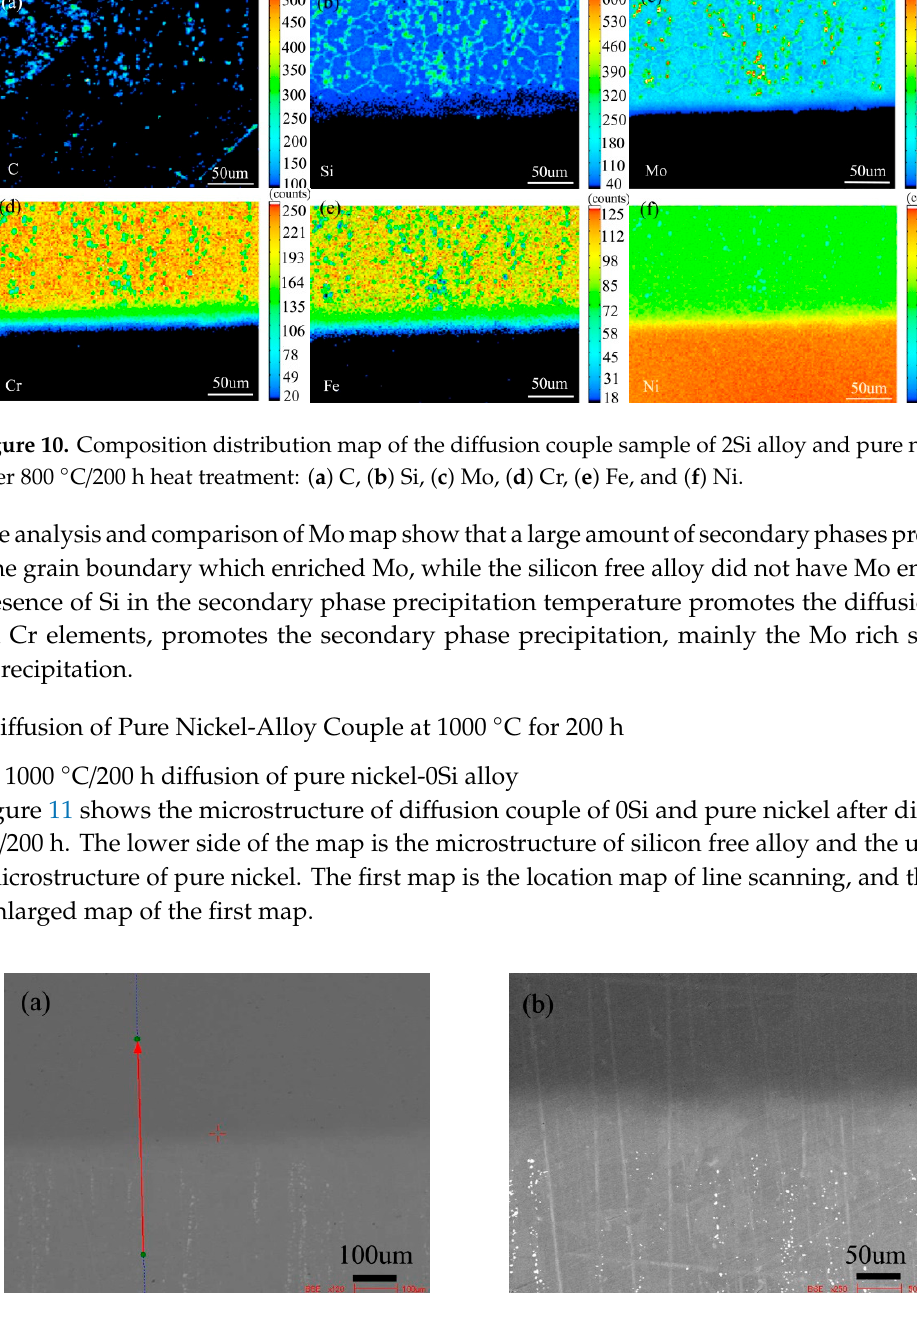
Figure 11. Microstructure of diffusion couple sample after 1000 °C/200 h heat treatment: ( a ) composition line scan position of the sample and the upper side is pure nickel material and lower side is 0Si alloy, ( b ) the enlarged view of map